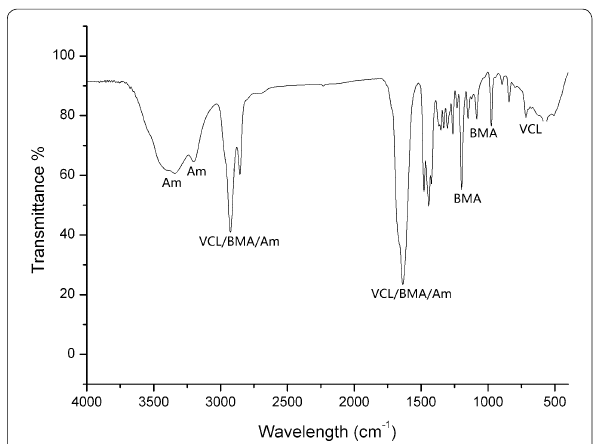
Fig. 3 FTIR spectrum of P VBAm . The polymer was introduced using the KBr method, the experimental wavelength used was the mid infrared band (4000–400 cm − 1 ) and the resolution 4 cm − 1